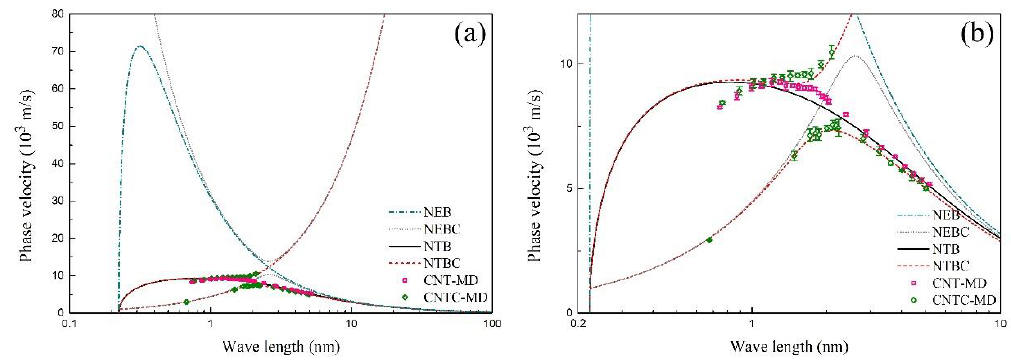
Figure 4. ( a ) The dependence of the phase velocity on the wave length of the SWCNT and the CCSC; ( b ) the zoom of ( a ).